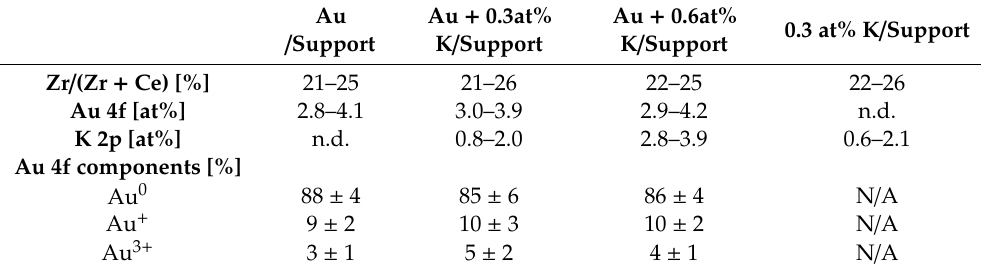
Figure 3. XPS results for Au 4f detailed regions of the catalysts: ( A ) Au/Ce 0.85 Zr 0.15 O 2 , ( B ) Au + 0.3 at%/Ce 0.85 Zr 0.15 O 2 , and ( C ) Au + 0.6 at%K/Ce 0.85 Zr 0.15 O 2 .